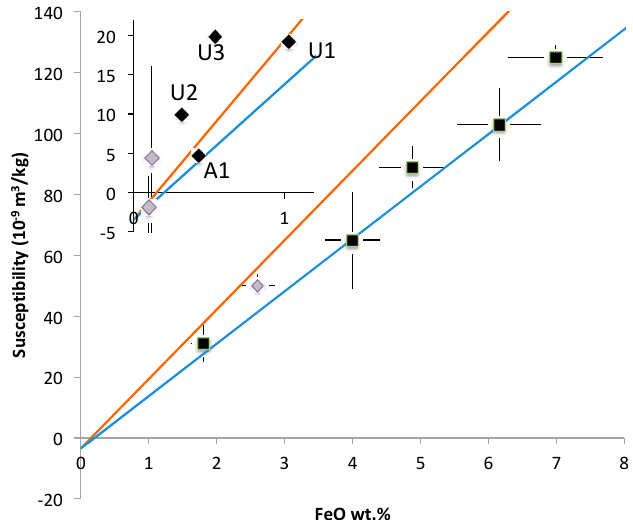
Figure 2. Magnetic susceptibility versus iron amount for tektite (black) and Darwin glass (grey), with theoretical curve for paramagnetic Fe 2 + and Fe 3 + (in blue and red, respectively), updated after [9]. Inset: iron poor glasses: LDG (grey), urengoite (U1, U2, U3), South-Ural glass (A1). Table 1. Magnetic susceptibility of tektites and Darwin glass ordered by FeO amount after [9] and this work, excluding anomalies over two times the average for australasite and belizite (see text). * and **: comparison with data from [20] and [21]. N is number of measurements (can be pooled specimens, or several specimens from one sample). When known the diameter in km of the source crater is indicated within